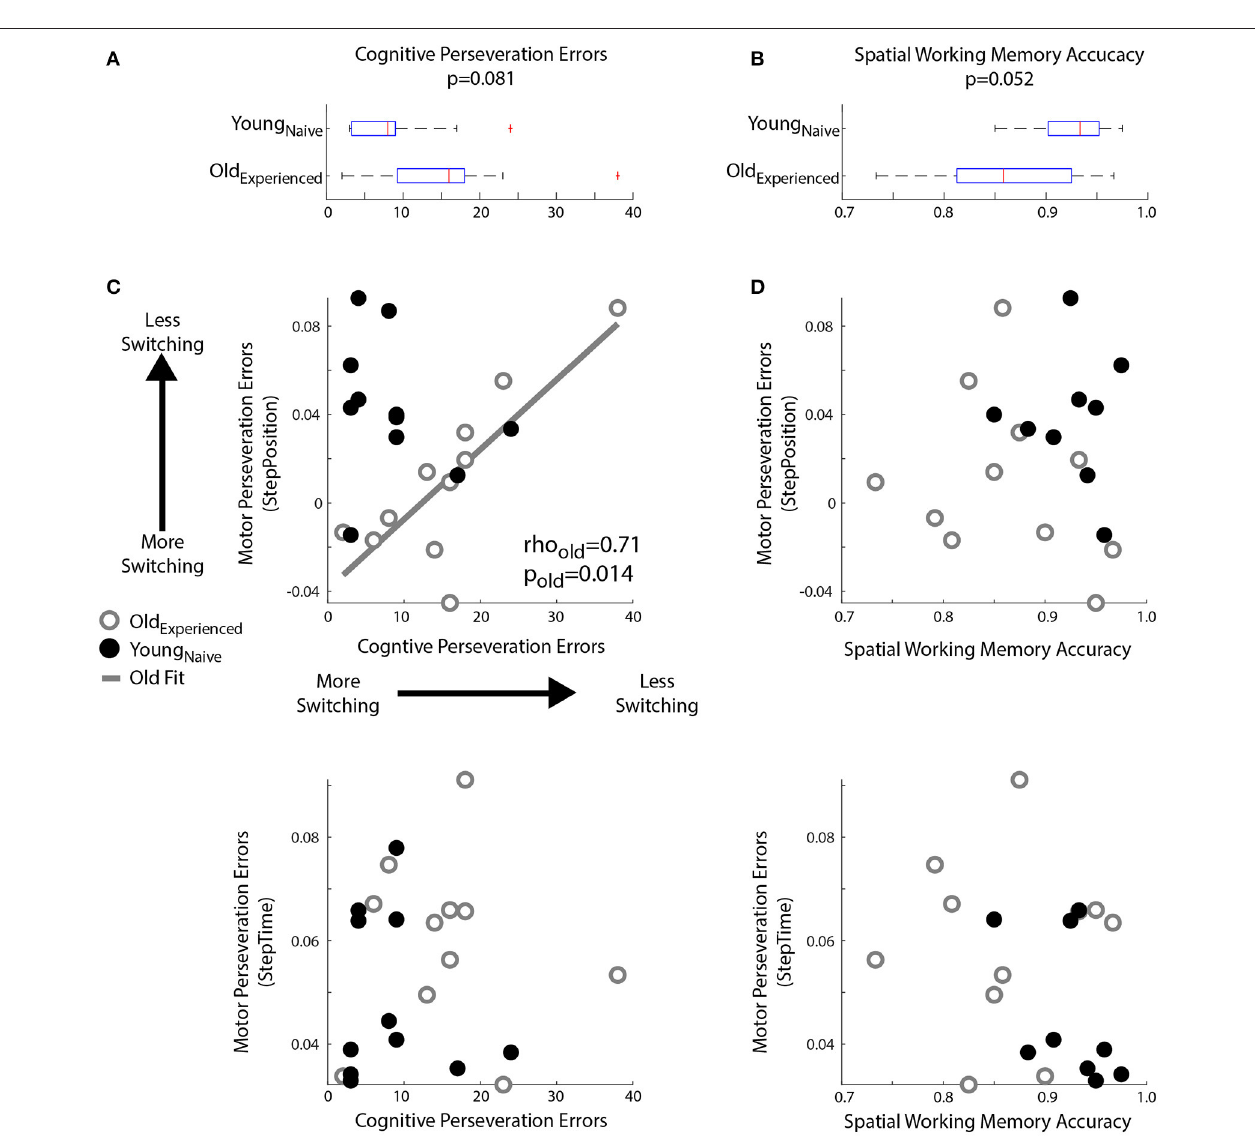
FIGURE 5 | Relationship between Motor and Cognitive Perseveration. (A,B) Box plots indicated age differences in (A) Cognitive Perseveration Errors accrued during the card matching task and (B) Spatial Working Memory Accuracy from the spatial working memory task. The middle, red line indicates the median values for the group, blue edges to the box represent the 25 and 75th percentiles. The whiskers indicate the range of the data excluding outliers, and outliers are shown as red markers. (C,D) Scatter plots indicate the relationship between perseveration errors in motor and cognitive tasks. A linear regression line was displayed when we found significant Spearman’s coefficients (C) Perseveration Errors: Larger Cognitive Perseveration Errors (x-axis) indicate more cognitive perseveration. Motor Perseveration Errors (y-axis) that are positive indicate that subjects cannot disengage the split-belt motor pattern upon transitioning to the overground context, whereas negative values indicate that subjects over-correct their movements upon this transition. Note a positive association between cognitive and motor perseveration errors in older (gray circles), but not younger adults (empty black circles). (D) Spatial Working Memory Accuracy: There is no relationship between Spatial Working Memory Accuracy and Motor Perseveration Errors for either older or younger